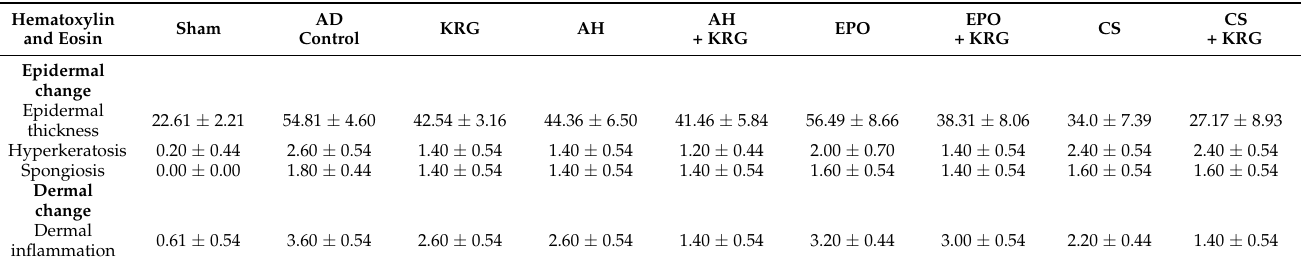
Table 1. A comparison of general histopathological patterns.